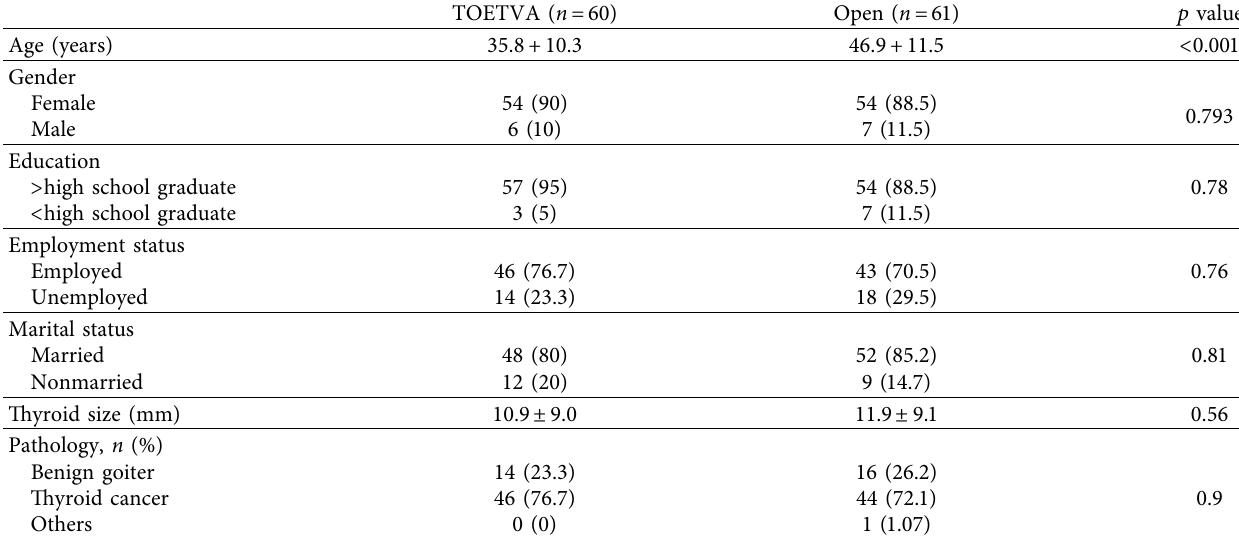
Table 1: Patient